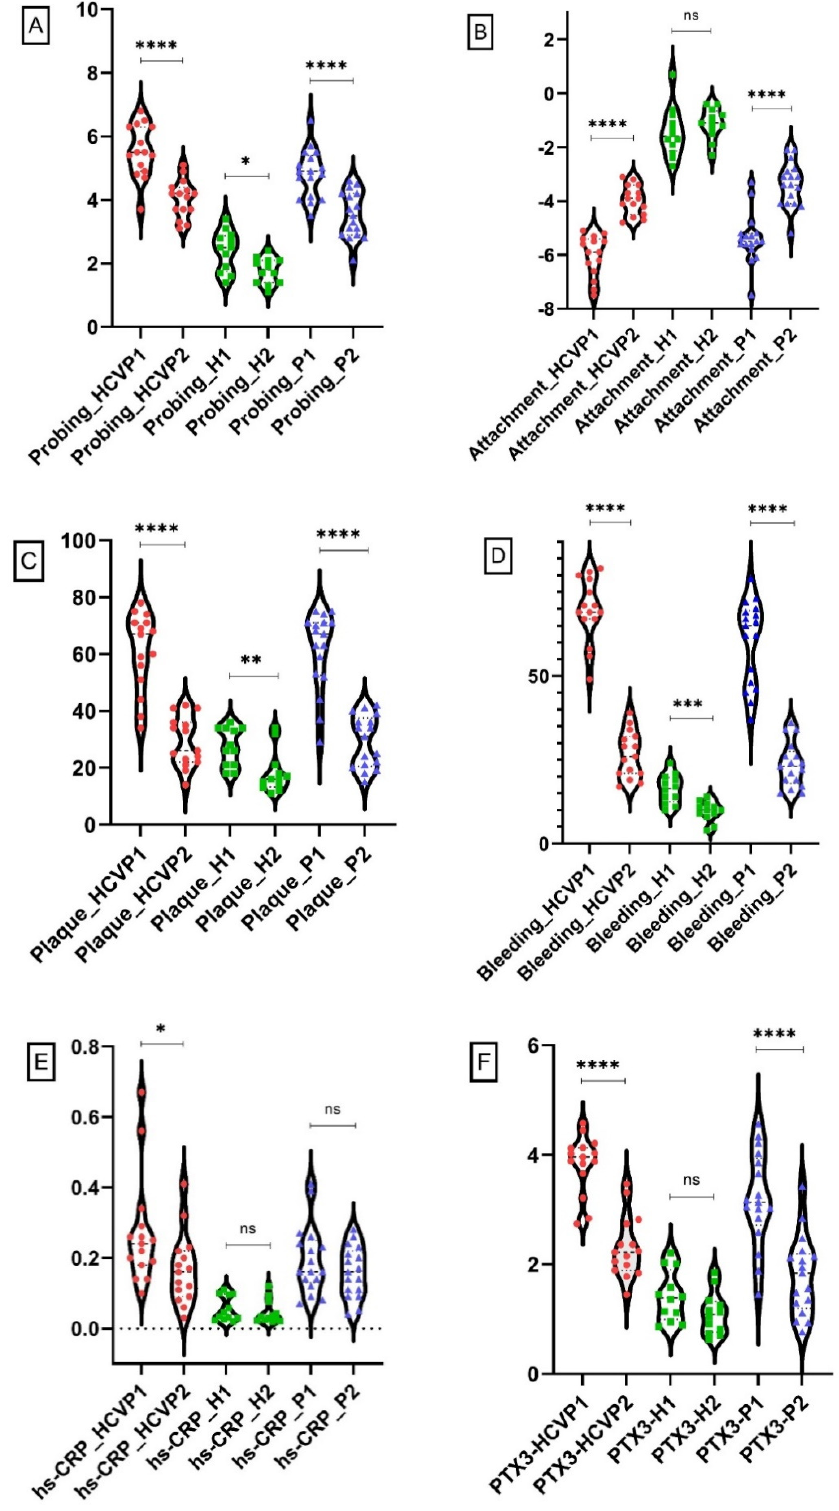
Figure 3. Levels of clinical and immunologic parameters baseline vs. recall. HCVP1 = HCV+P group baseline; HCVP2 = HCV group recall; P1 = P group baseline; P2 = P group recall; H1 = H group baseline; H2 = H group recall. ( A ) Mean probing depth. ( B ) Mean attachment level. ( C ) Plaque. ( D ) Bleeding on probing. ( E ) hs-CRP. ( F ) PTX3. Data were analyzed for statistical significance using Mann-Whitney tests between groups. *, p < 0.05; **, p < 0.01; ***, p < 0.001; ****, p < 0.0001; ns = not significantly different. Table 4. Evolution (%) of analyzed parameters from baseline to recall.